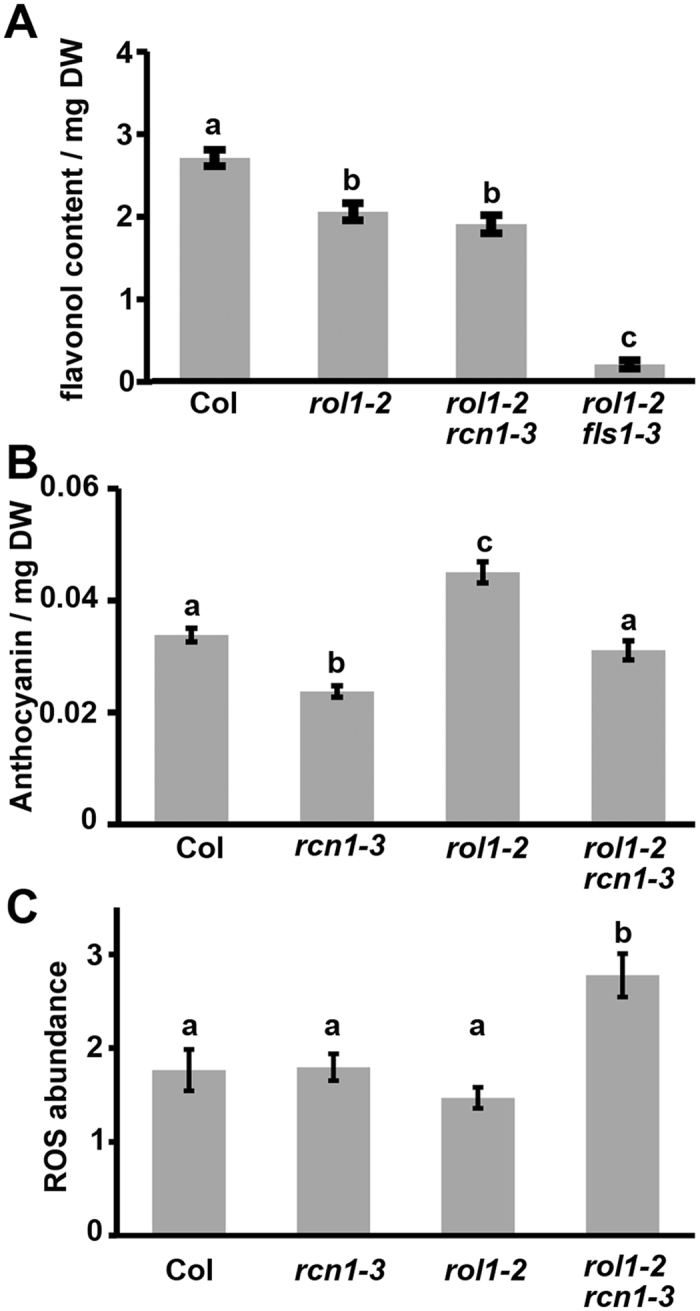
Phenylpropanoid and ROS contents in seedlings.(A)
rol1-2 rcn1-3 seedlings show rol1-2 like flavonol levels in shoots, that correspond to 70% of the wild-type (Col) levels. As a comparison, rol1-2 fls1-3 mutants are almost devoid of flavonols. Area under the flavonol peaks per mg dry weight was used to quantify flavonol content. (B) The anthocyanin content was measured in entire seedlings and revealed to be reduced in the lines containing the rcn1-3 mutation. (C) ROS are quantified by fluorescence emitted by the ROS-specific dye CM-H2DCFDA. The tip-area of at least 10 roots was used for each data point. Quantification of ROS revealed comparable levels in the wild type, rol1-2, and rcn1-3 but a significant increase in the rol1-2 rcn1-3 double mutant. Different letters indicate significant difference between samples (t-test, P < 0.05).